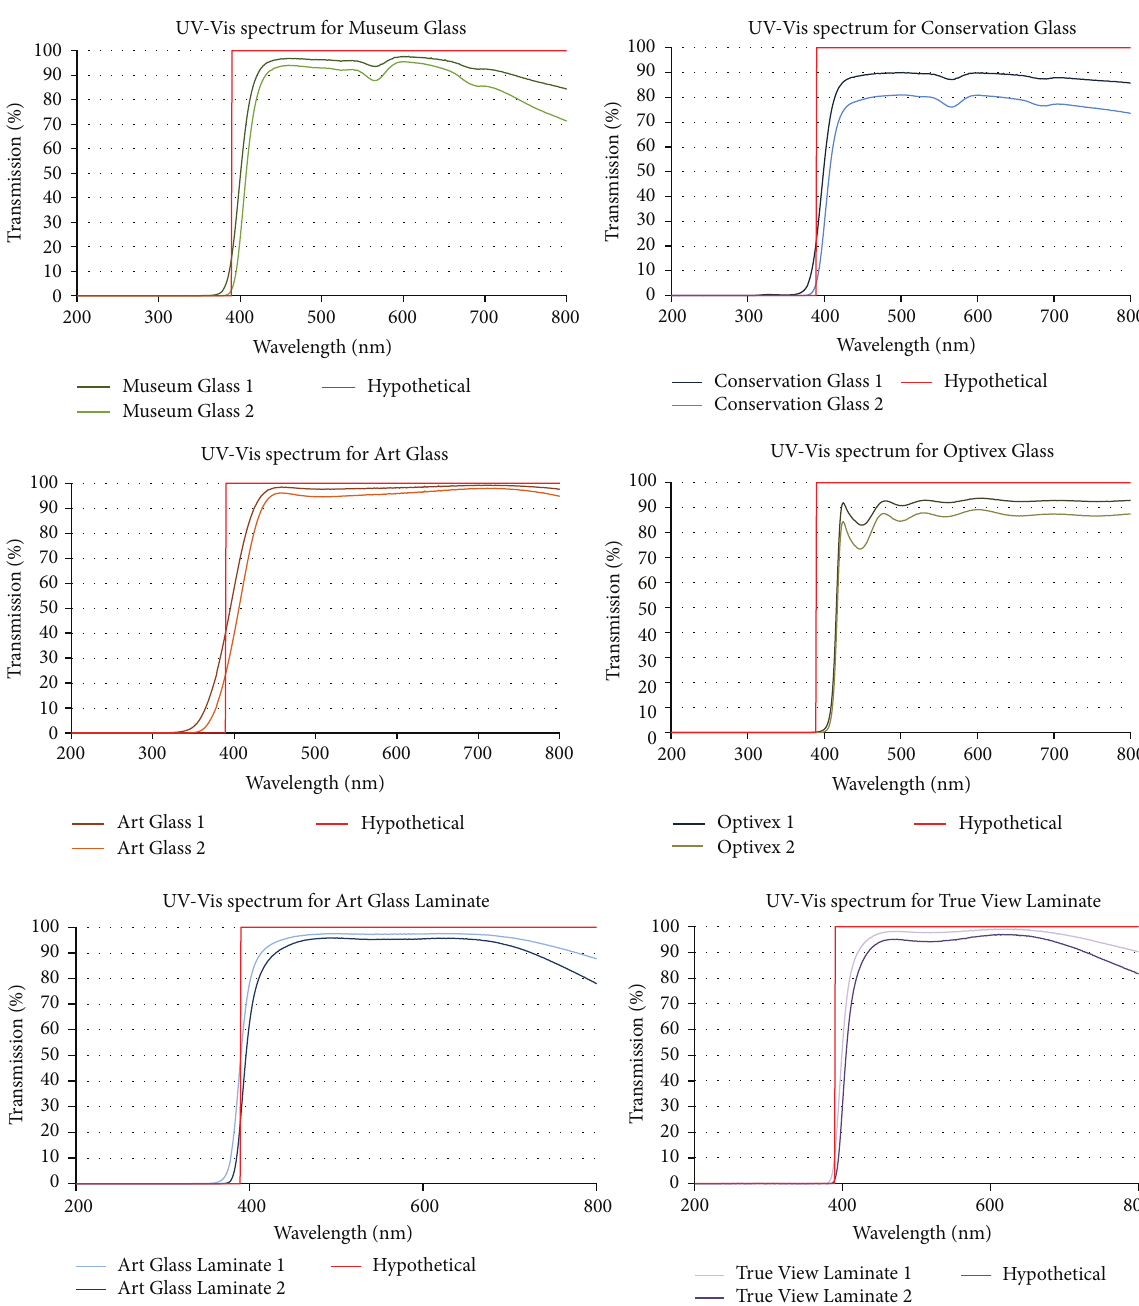
Figure 1: Data for the % transmission for each of the samples plotted against the hypothetical ideal plot; the number in the sample names indicates the number of sheets of the sample glass that were